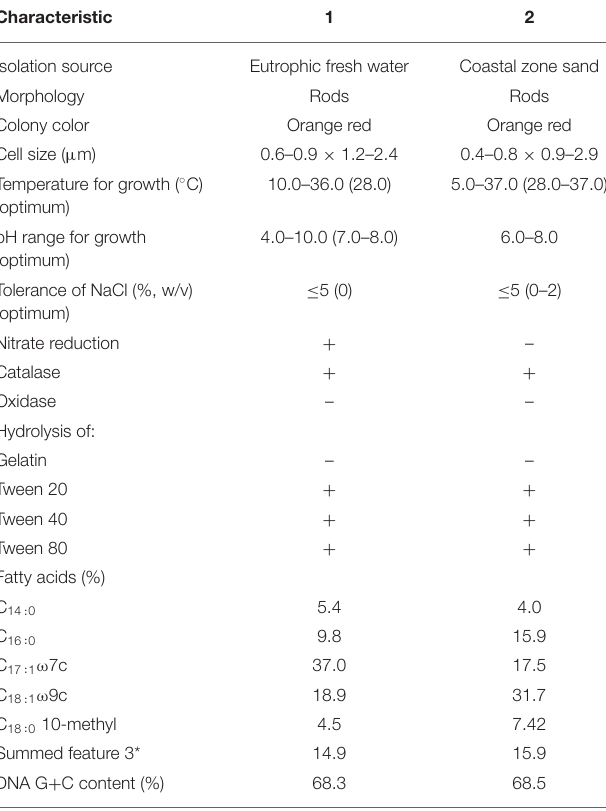
TABLE 1 | Phenotypic and biochemical characteristics of strain JXJ CY 35 T and the reference strain.